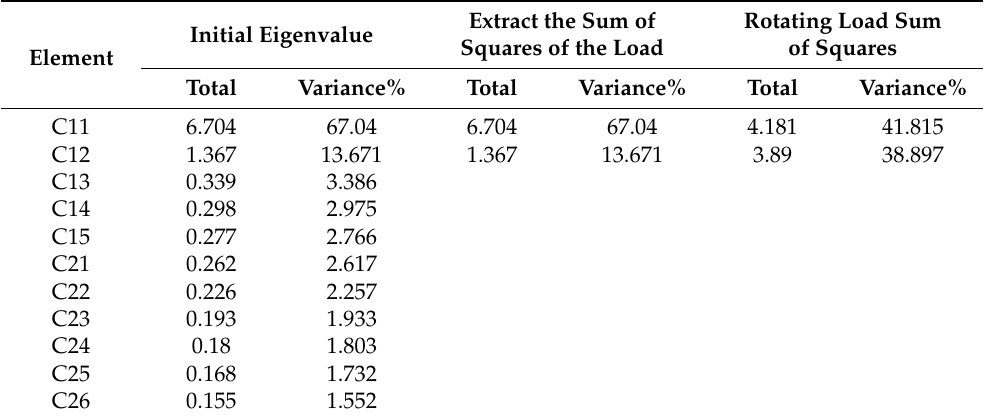
Table A5. Employee Work Performance Total Variance Explained.